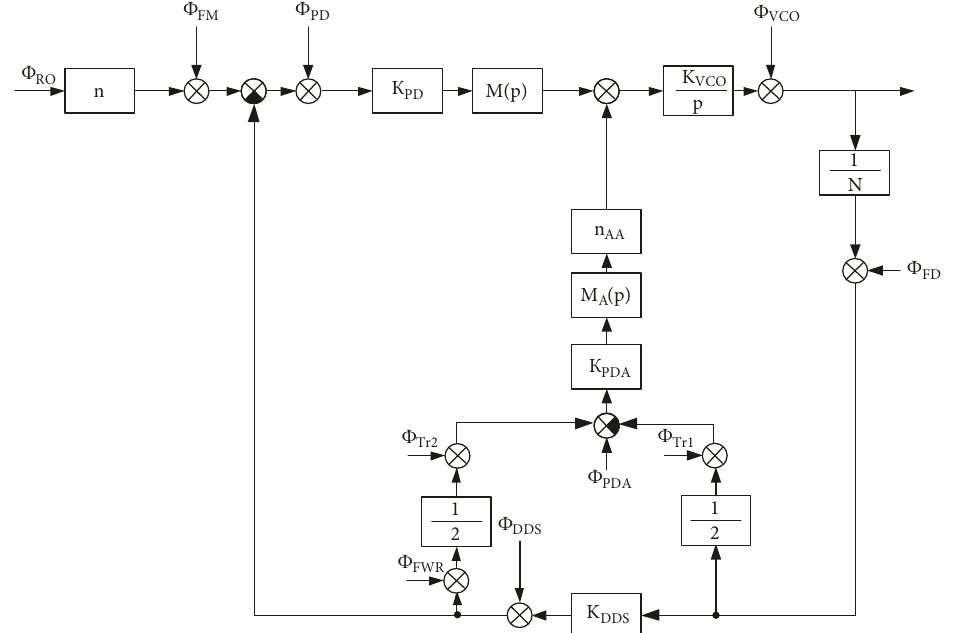
Figure 8: Equivalent circuit of the channel for forming signals with the DDS as a frequency divider in the feedback loop of the PLL with all sources of phase